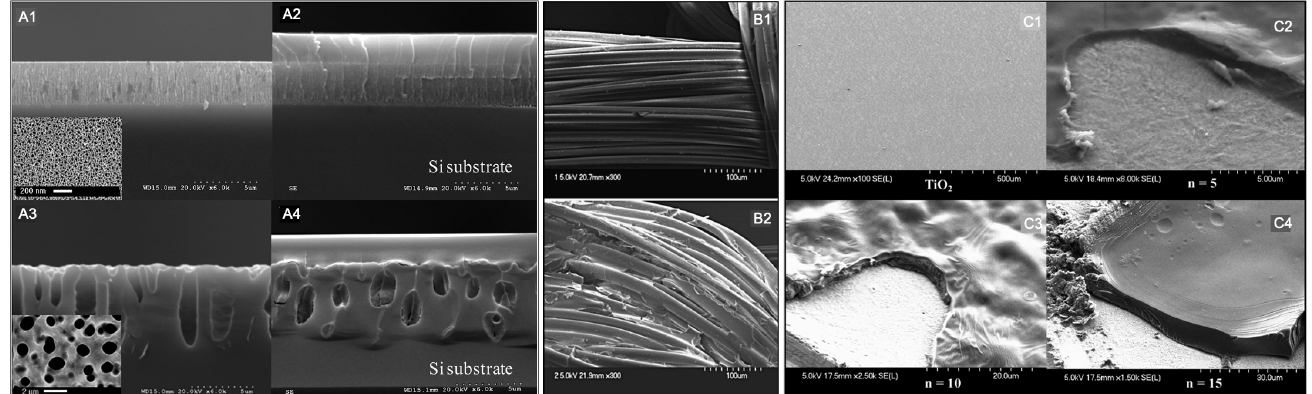
Figure 5. SEM images of: ( A1 ) nPSi, ( A2 ) nPSi- β -CD/CTR, ( A3 ) mPSi, ( A4 ) mPSi- β -CD/CTR; ( B1 ) PET visceral mesh, ( B2 ) PET-HP- β -CD/CTR, ( C1 ) Ti, ( C2 ) Ti-LbL of 5 bilayers, ( C3 )Ti-LbL of 10 bilayers, and ( C4 ) Ti-LbL of 15 bilayers. Bilayers are chitosan and β -CD/CTR. Adapted from [8,10,44], with permission from Elsevier and